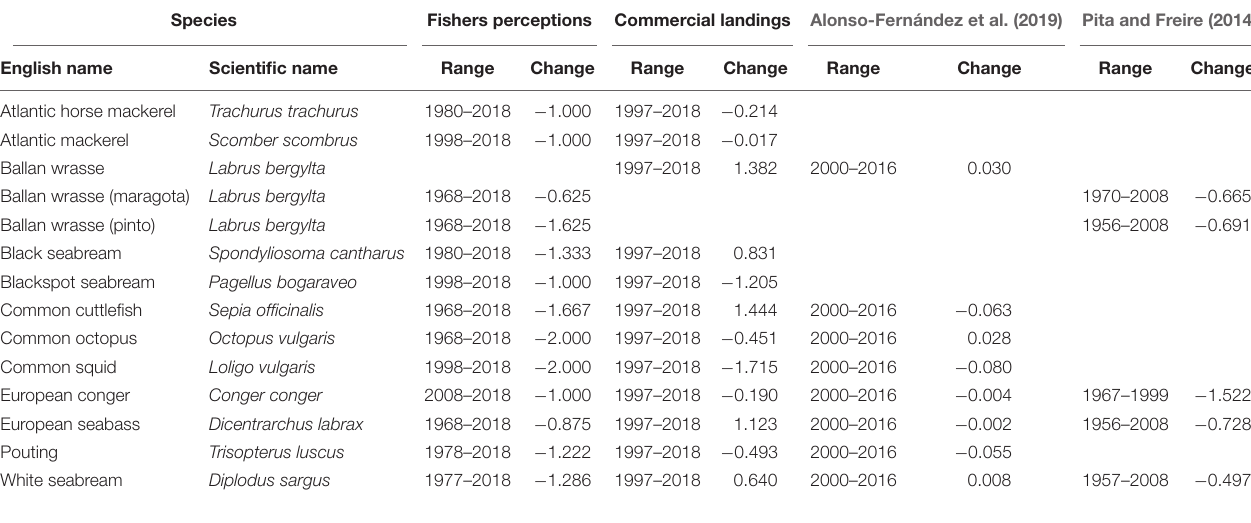
TABLE 2 | Comparison between temporal changes in perceived conservation status of fish stocks targeted by recreational fishers (from − 2 meaning very negative to 2 meaning very positive) and temporal trends for the same species in commercial landings [abundance (Alonso-Fernández et al., 2019) and size (Pita and Freire, 2014)].